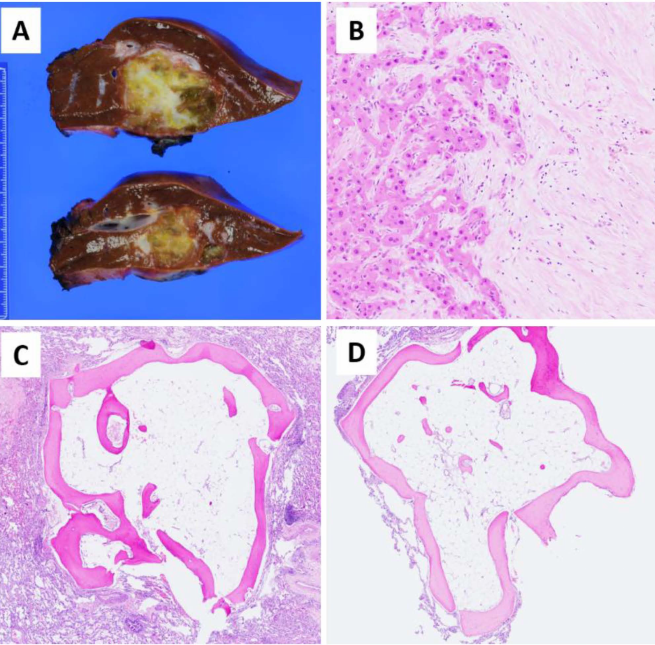
Figure 3. Pathological findings of a patient with Fibrolamellar Hepatocellular carcinoma (FL-HCC) and bilateral diffuse nodular pulmonary ossification (PO). Cross-section of the left hepatectomy showing a 5.6 × 5.0 × 3.6 cm tan-gray, necrotic appearing, and relatively well-circumscribed mass ( A ). Post-chemotherapy FL-HCC with areas of viable residual tumor (left side) composed of thick trabeculae of large polygonal cells separated by dense desmoplastic collagenous stroma aside areas of necrosis and chemotherapy-induced changes (right side). Hematoxylin & Eosin, 200 × ( B ). Lung parenchyma with multiple nodules composed of a rim of well-organized lamellar bone and mature adipose tissue consistent with diffuse nodular PO. No inflammatory infiltrate, no granulomatous reaction, and no tumor cells were noted. Hematoxylin & Eosin, 40 × ( C , D